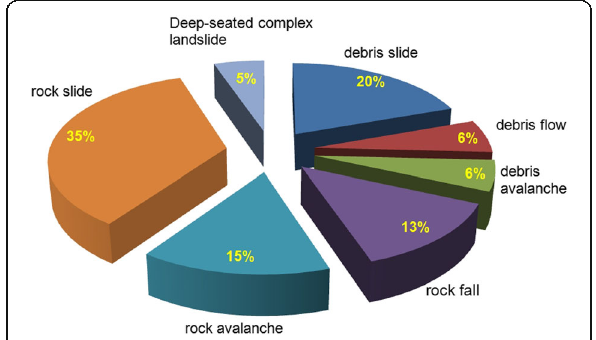
Fig. 2 Pie Chart of the classification of the damming landslides induced by the Wenchuan